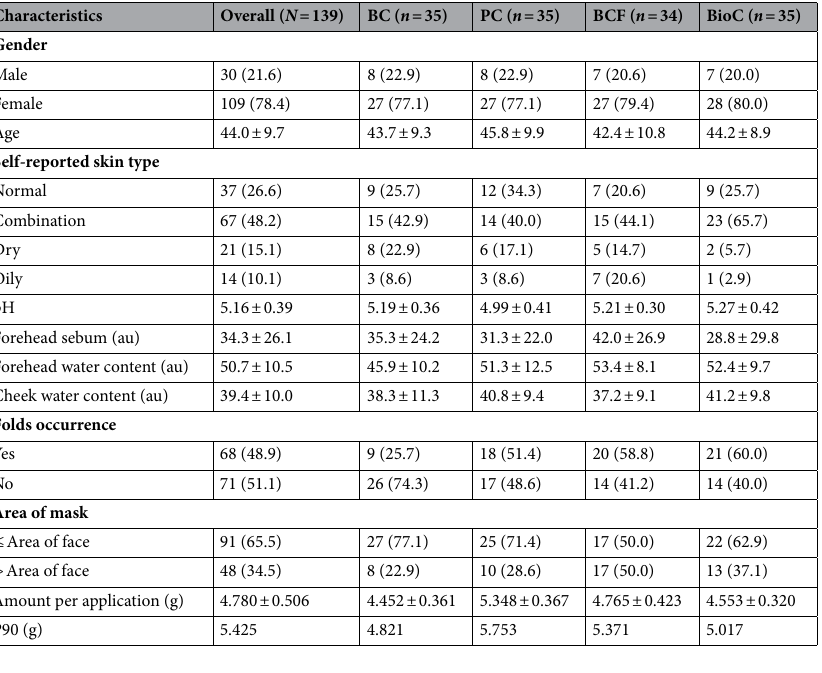
Table 1. General characteristics of the subjects [ n (%) or mean ± SD]. BC binchotan charcoal fiber, PC plant cellulose, BCF bamboo charcoal fiber, BioC